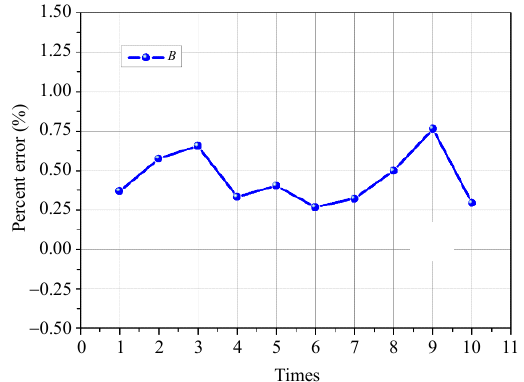
Fig. 4 Relative error distribution for adding or reducing scales